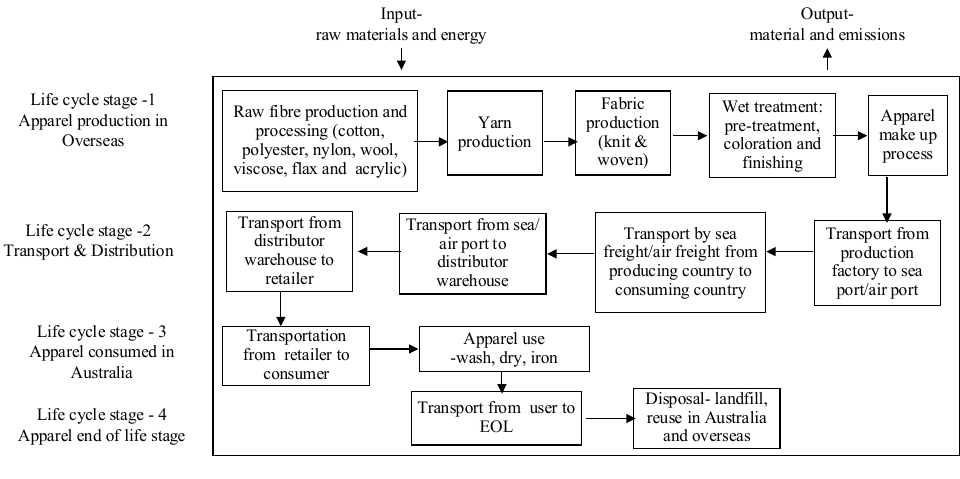
Fig. 2. System boundary of this